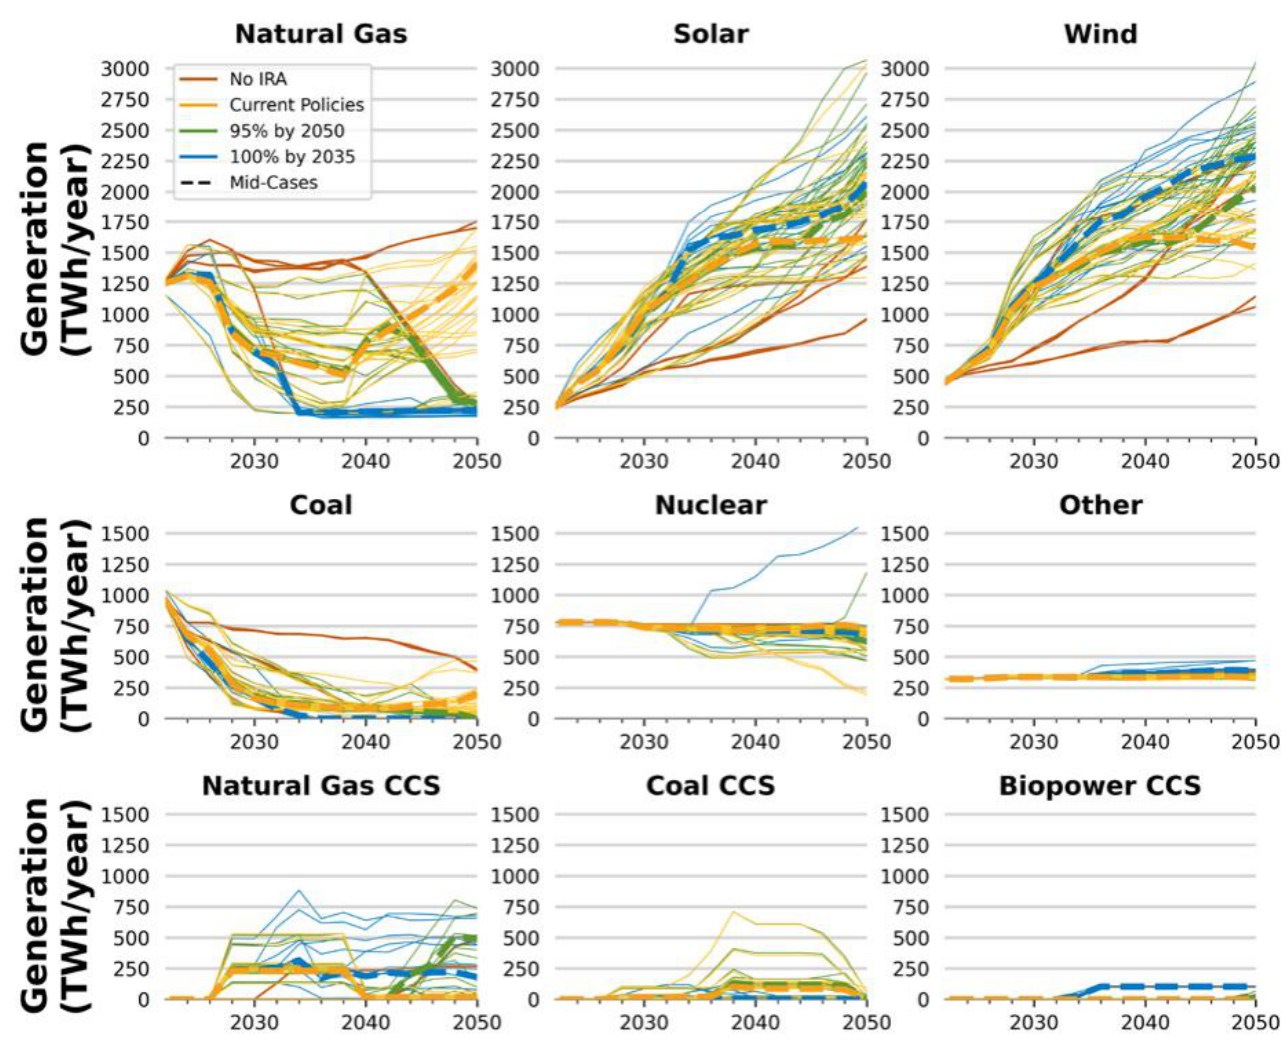
Figure 4. Generation across the suite of scenarios by fuel type [97]. Reprinted with permission from the National Renewable Energy Laboratory, https://www.nrel.gov/docs/fy23osti/84327.pdf (accessed on 7 April 2023).